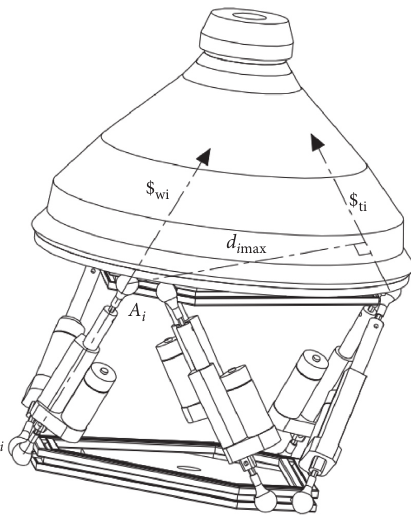
Figure 3: The position of $